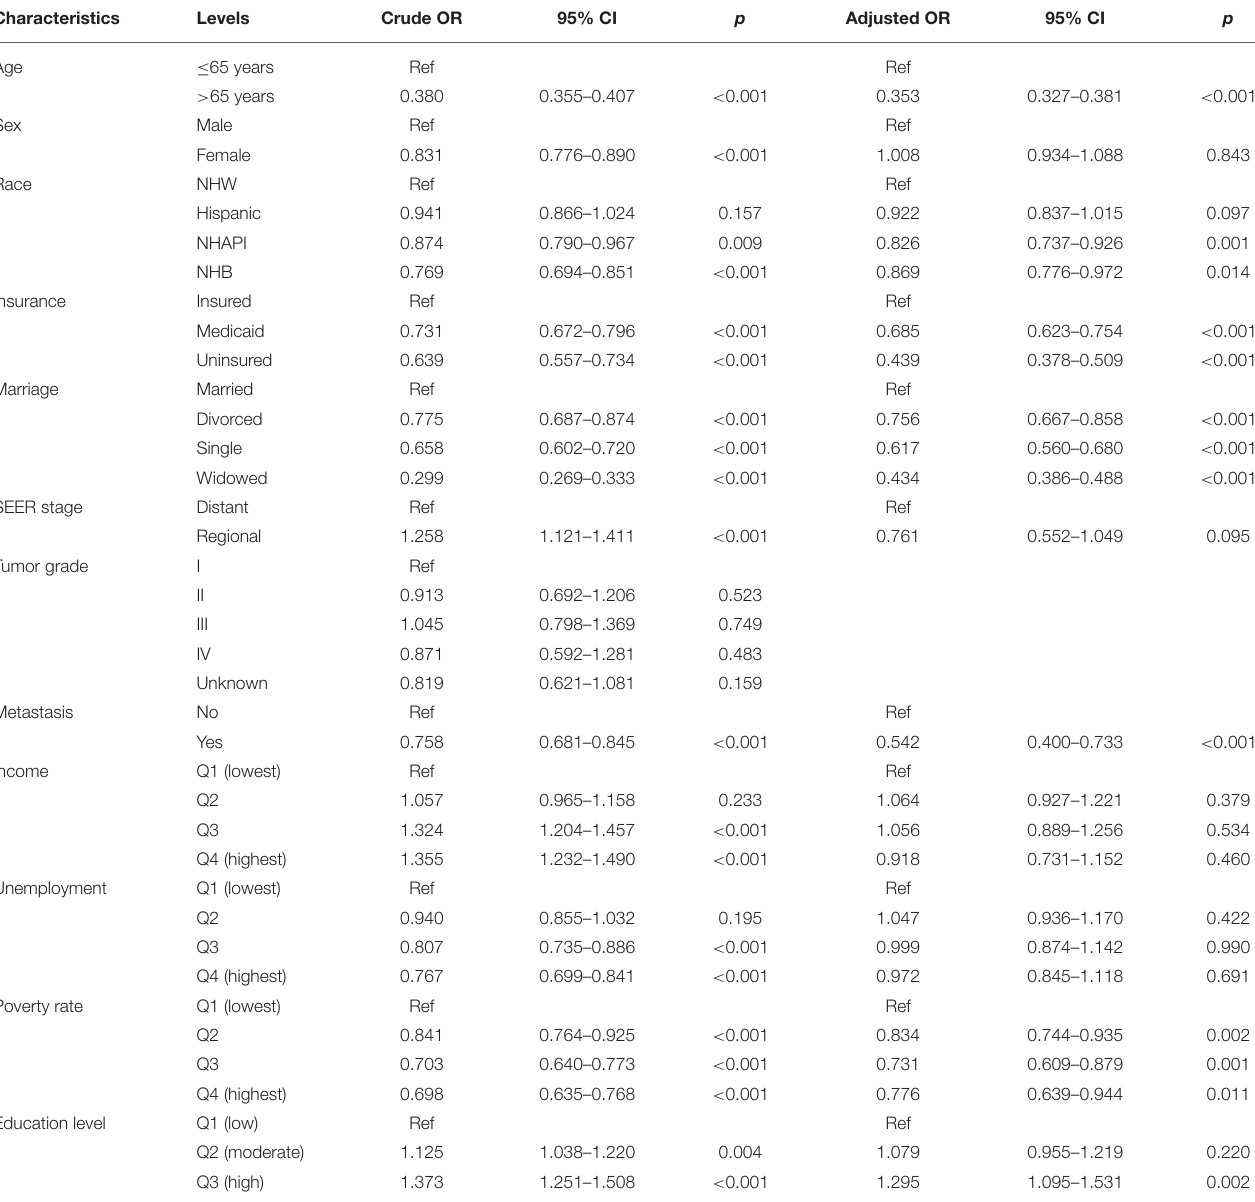
TABLE 4 | Univariate and multivariate logistic regression analysis of chemotherapy receipt in AJCC stage IV patients.